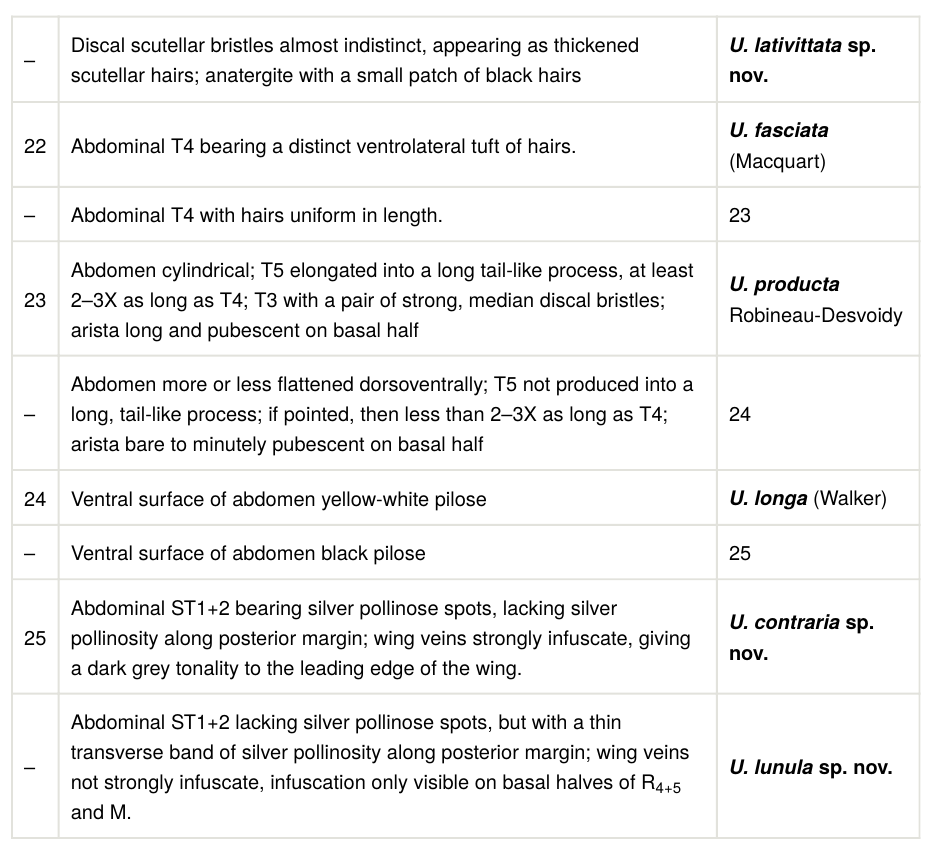
pollinosity along posterior margin; wing veins strongly infuscate, giving a dark grey tonality to the leading edge of the wing.